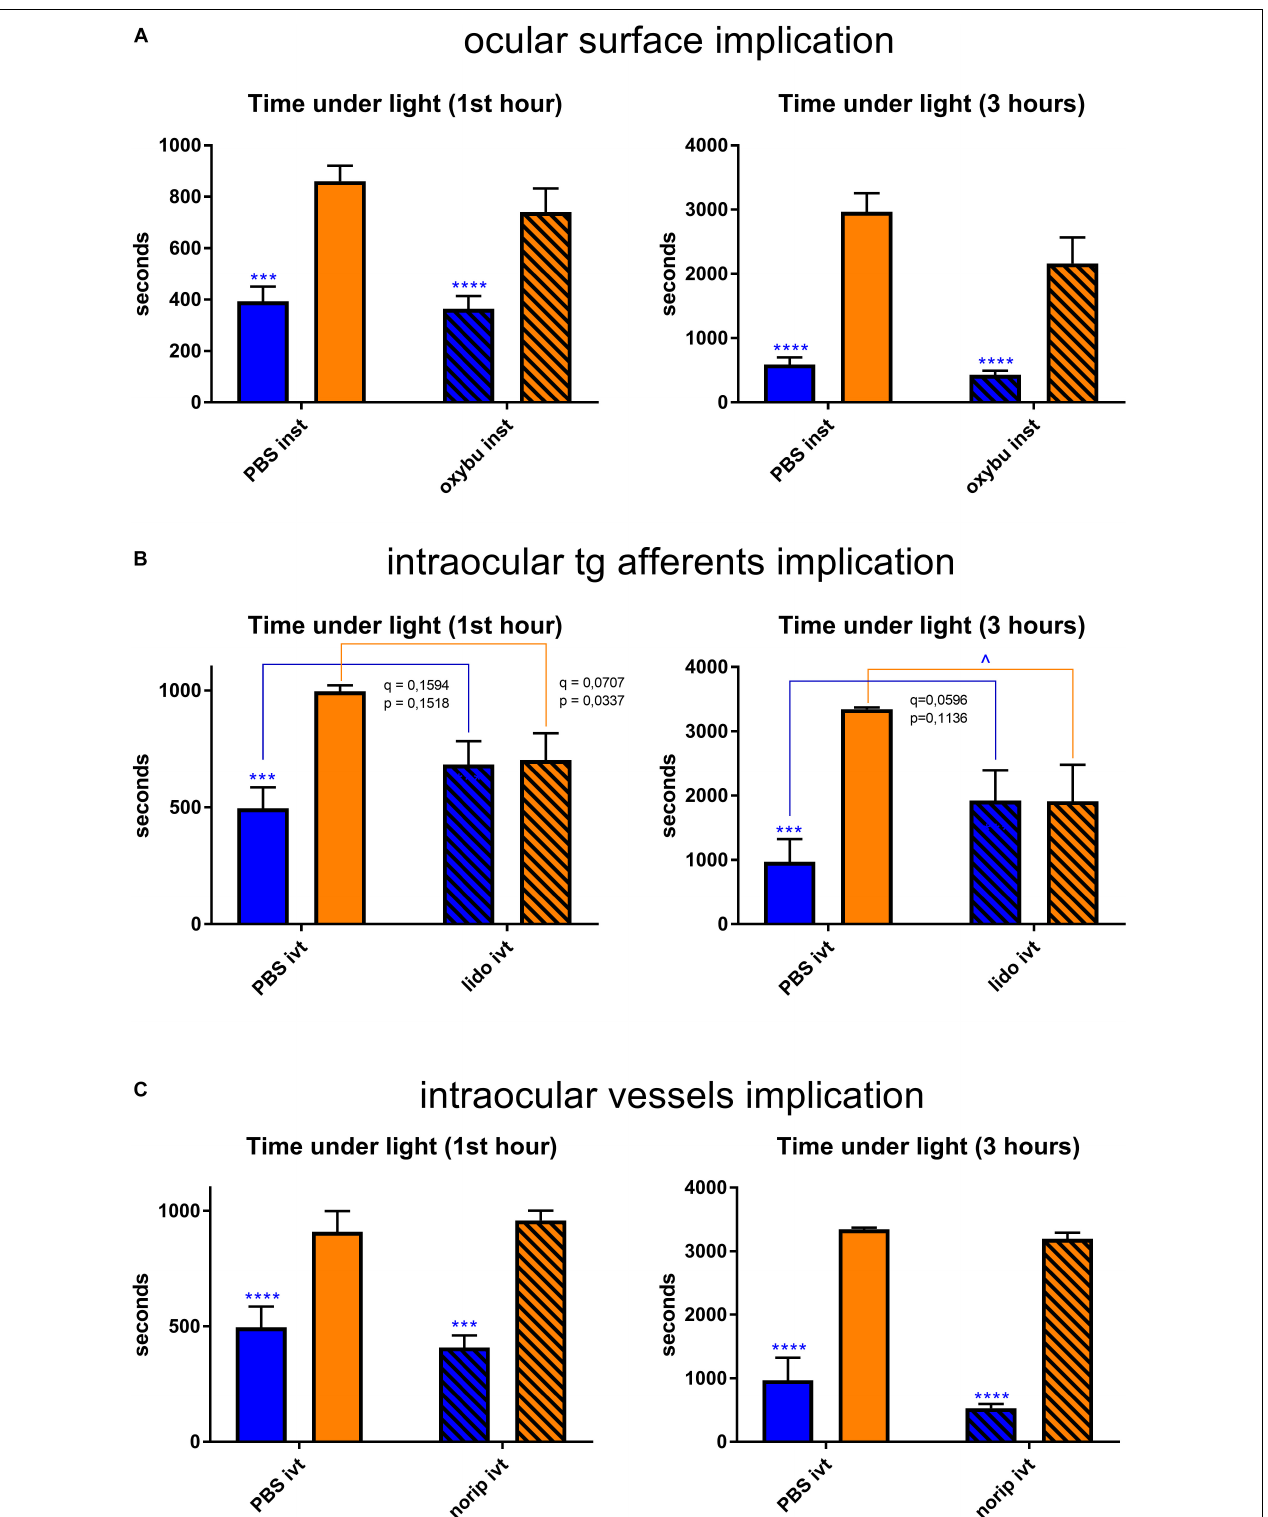
FIGURE 9 | Trigeminal pathway-related behavioral tests. Graphs illustrate the time spent in the illuminated part of the box during the chosen representative periods. For more detail, see “Materials and Methods” section. (A) Ocular surface was anesthetized with oxybuprocaine ( oxybu ). One drop per eye was instilled ( inst